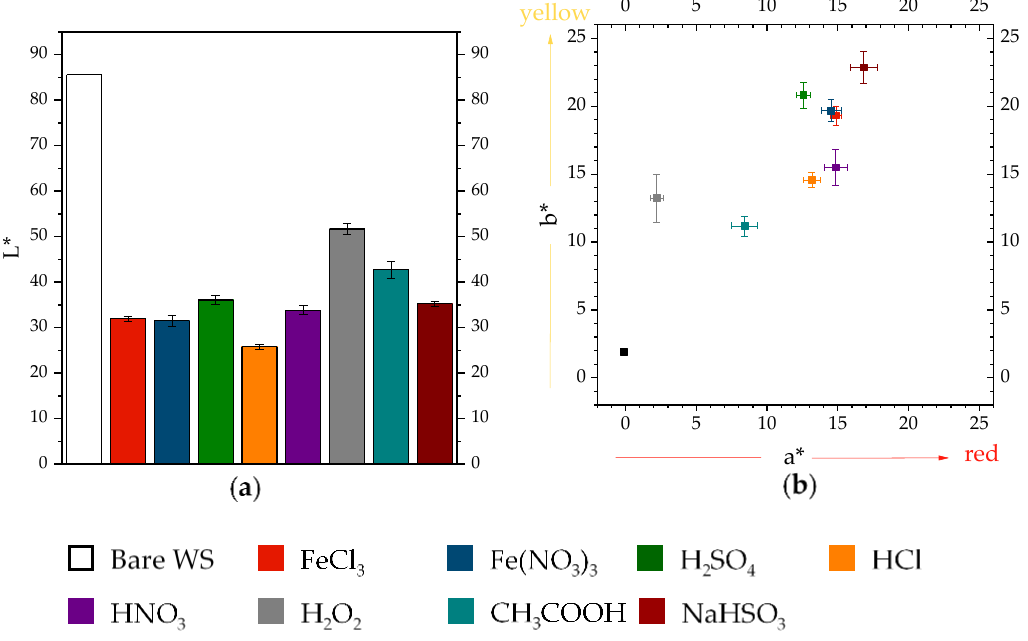
Figure 6. Lab values of the bare metal and the accelerated patinas at zero time: ( a ) L* value and ( b ) a* versus b* values.